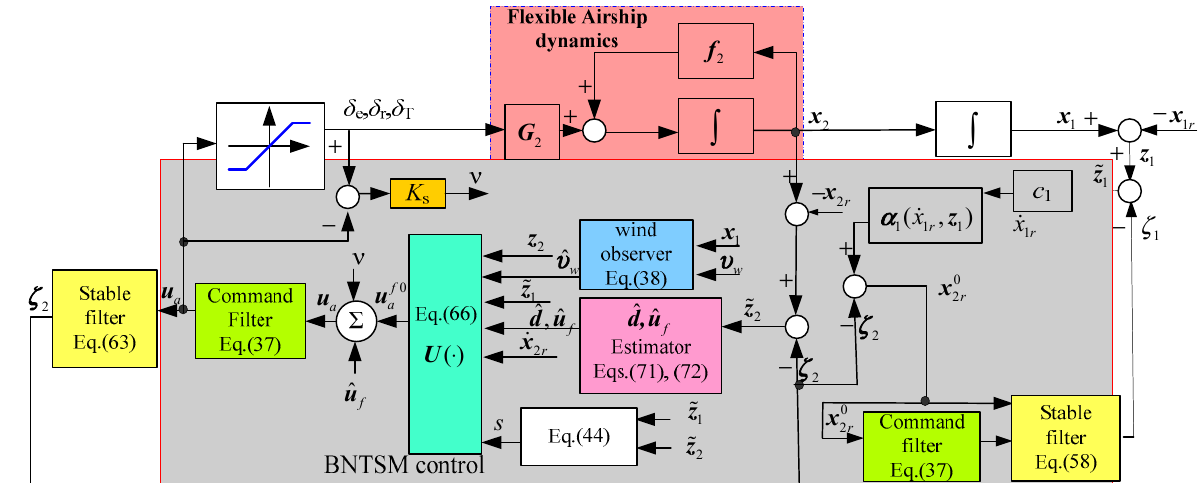
Figure 2. Block diagram of the proposed BNTSM controller.